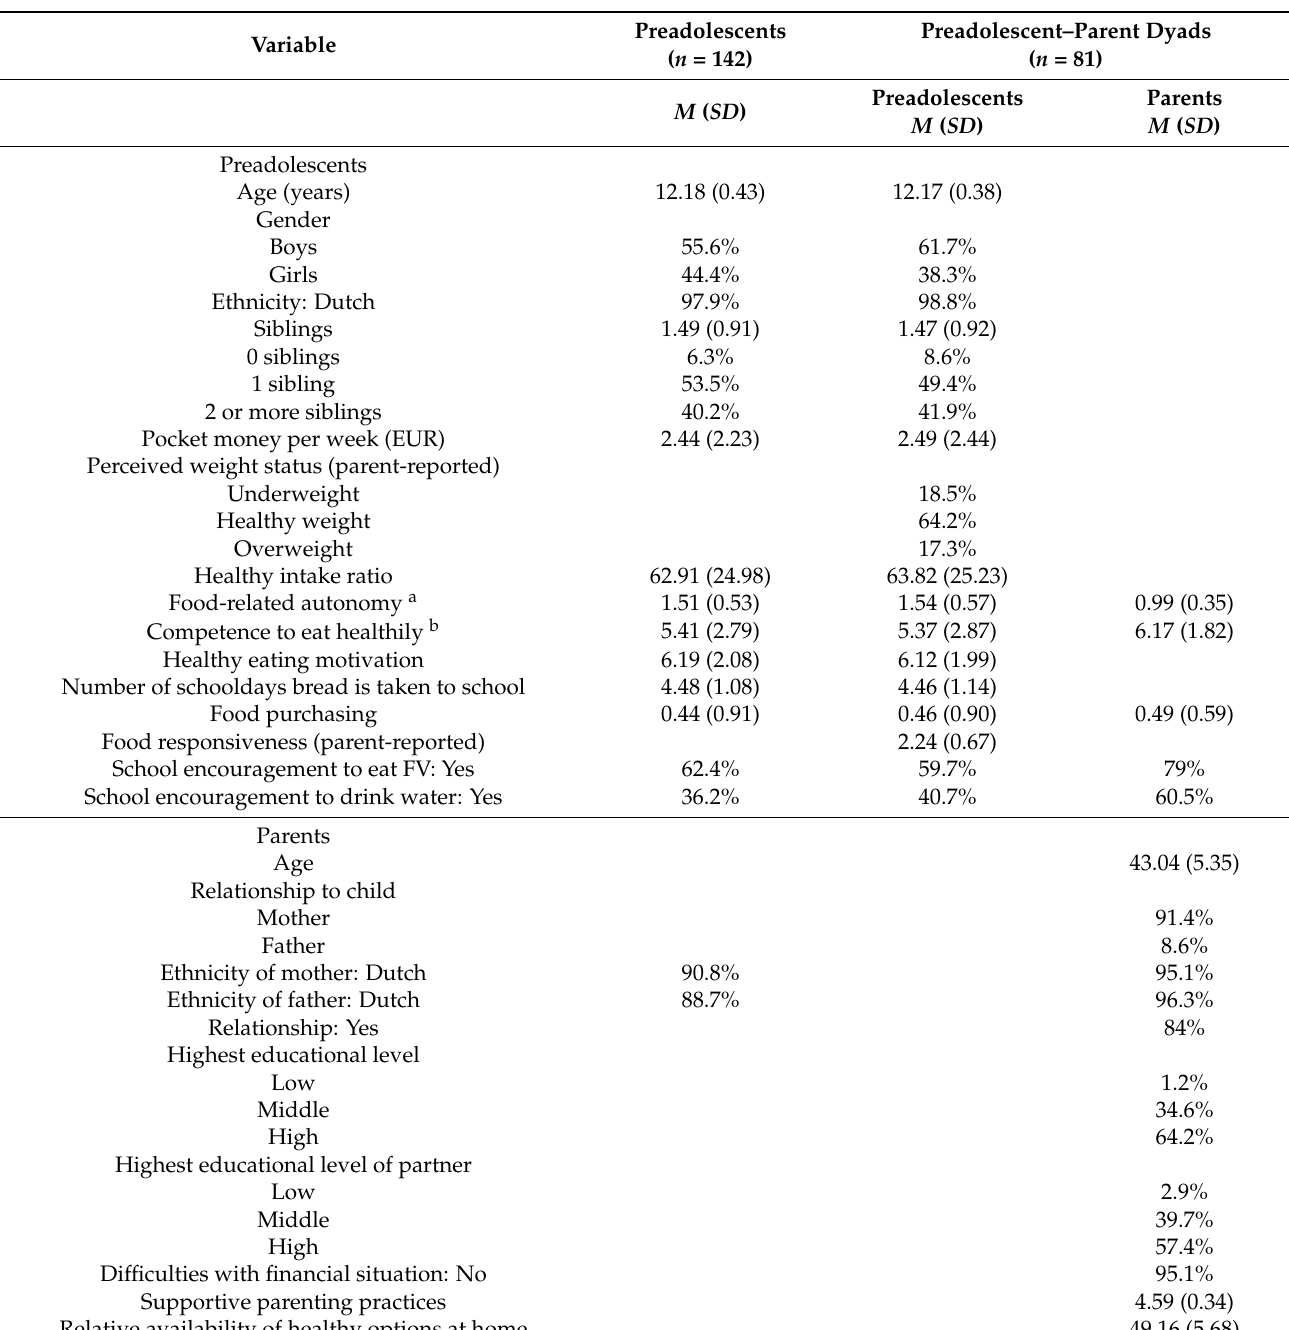
Table 2. Descriptive statistics of study